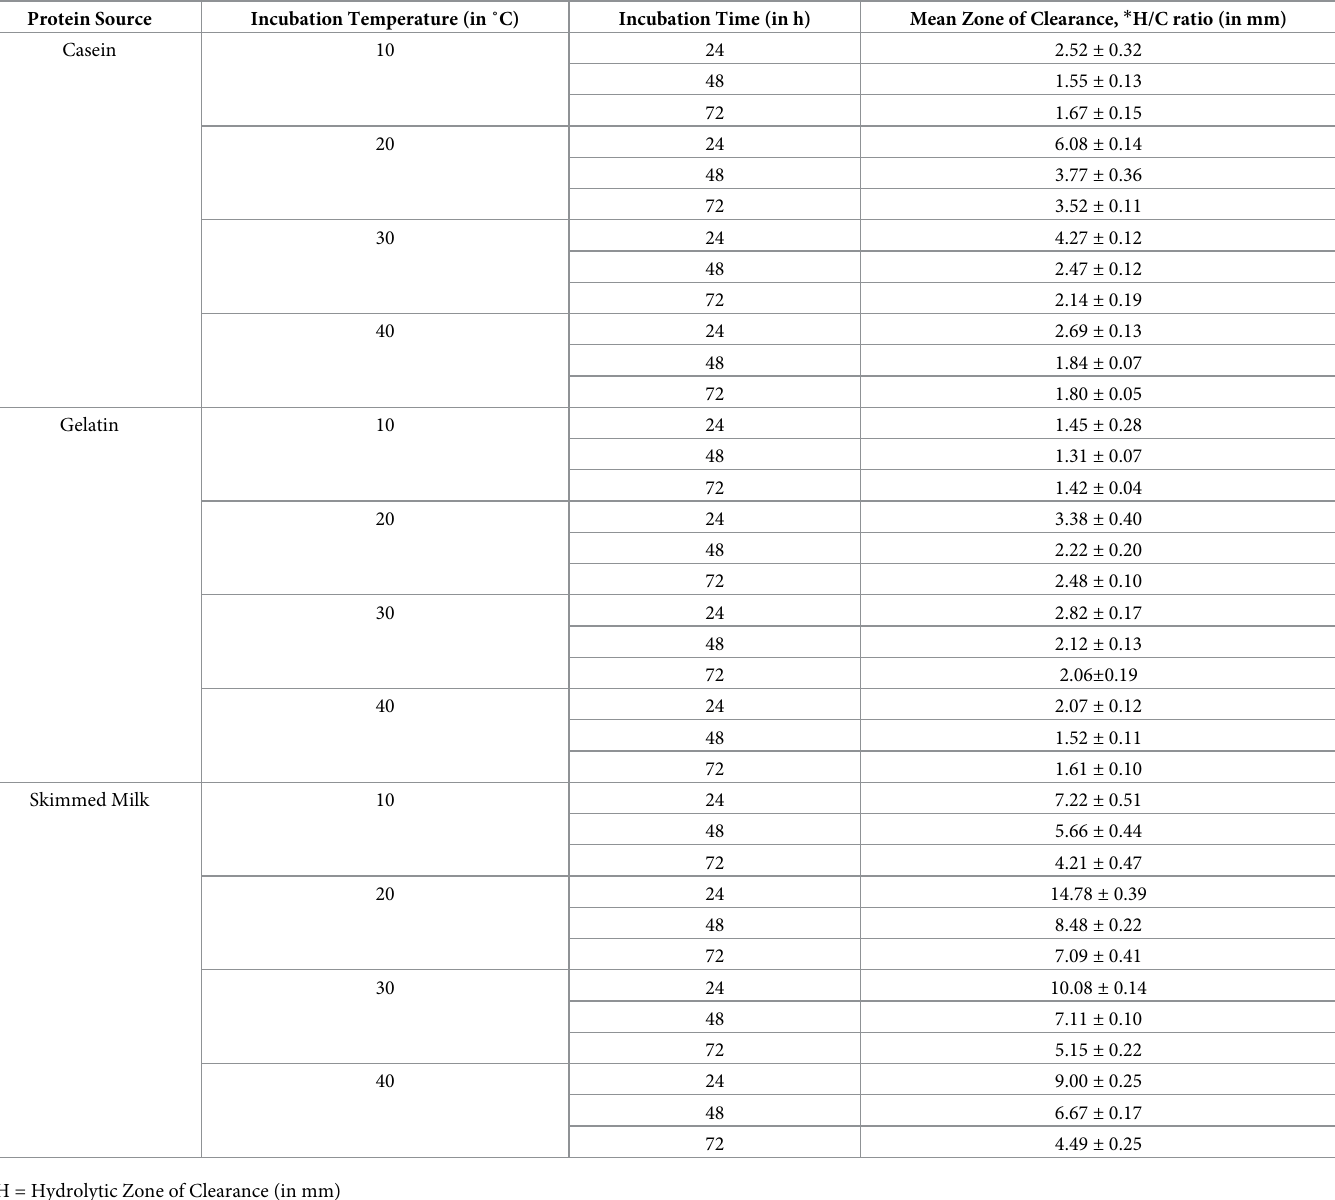
Table 2. Primary screening of proteolytic bacteria, HM49 on different media at different temperatures.